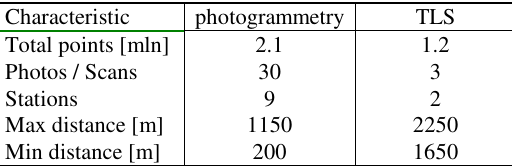
Table 2. Summary of data